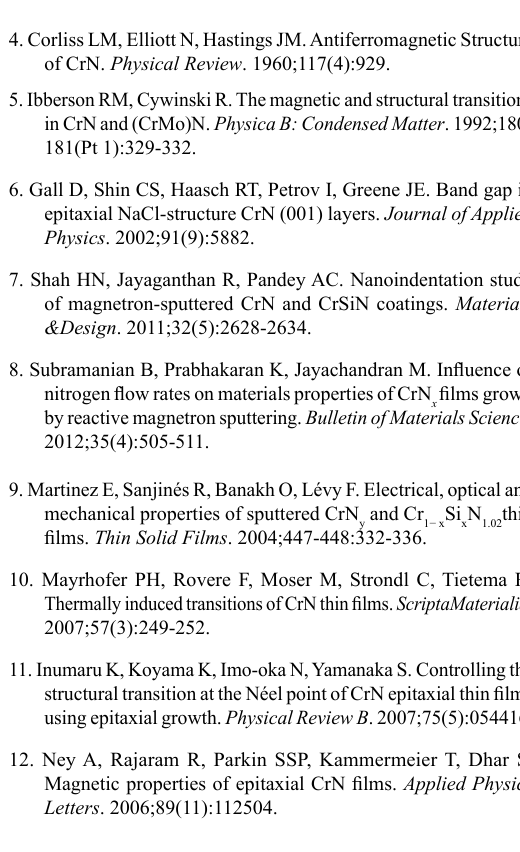
Figure 5. Fitting curve of t = 90 nm CrN/Si (100) in the semiconducting (284-400 K) region.